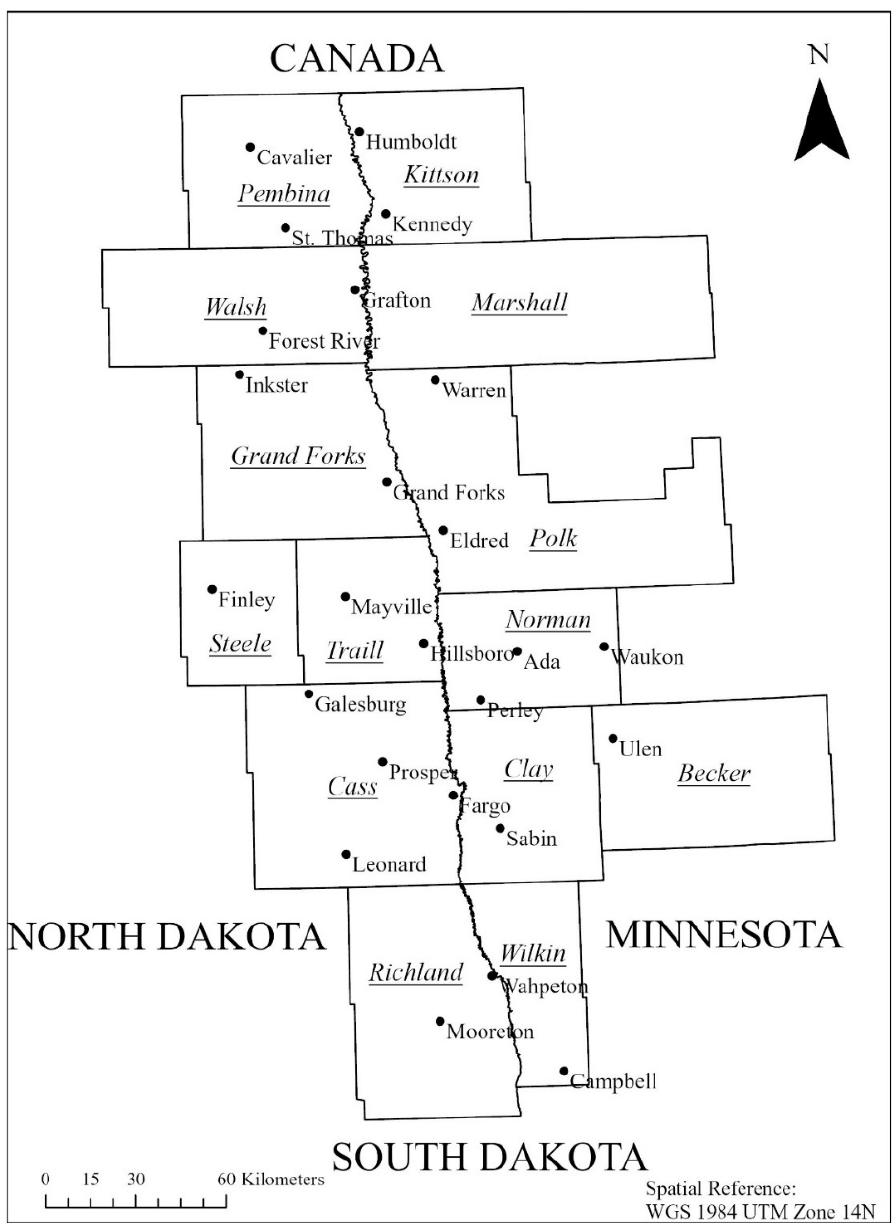
Figure 1. Location of NDAWN stations in counties of ND and MN around the RRVN.